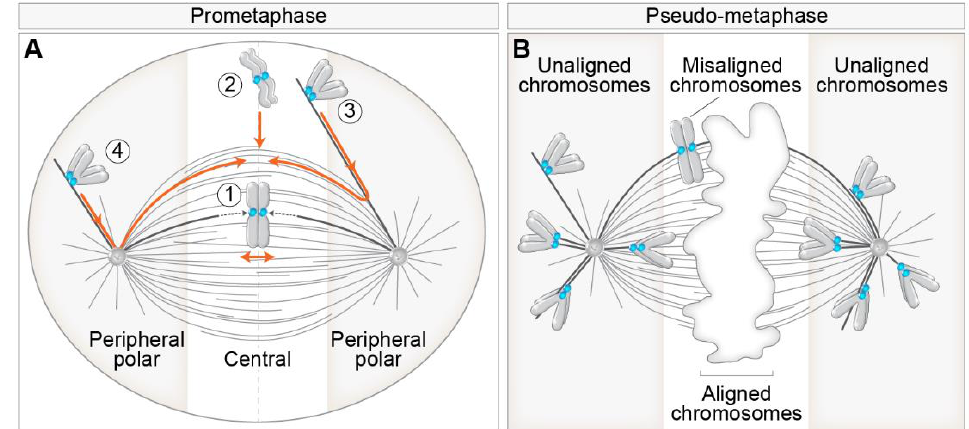
Figure 1. Different routes to chromosome alignment based on the initial position of chromosomes with respect to spindle poles and consequences of aberrant alignment during pseudo-metaphase. ( A ) Initial position of chromosomes with respect to spindle poles defines motor-dependent (peripheral polar) and independent (central) regions important for chromosome alignment during early prometaphase. Different pathways to chromosome alignment to spindle midplane, noted with a circled number, are depicted in orange color. Peripheral polar and central regions are indicated by grey and white color, respectively. Centrosomes are labeled as circles with two centrioles inside. The dotted lines within the spindle indicate microtubule growth. ( B ) Definition of aligned, misaligned, and unaligned chromosomes in the pseudo-metaphase spindle. The white area in the middle of the pseudo-metaphase spindle denotes chromosomes aligned within the metaphase plate. The boundaries between the peripheral polar and central regions signify the dependence on kinetochore motors for alignment. In all figures, please see the text for details and references.